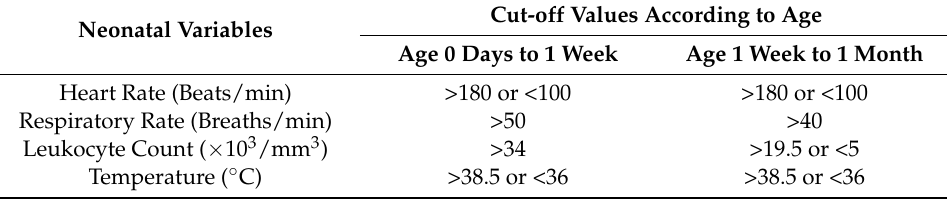
Table 1. Systemic inflammatory response syndrome (SIRS) cut-off values for neonates according to the International Pediatric Sepsis Consensus